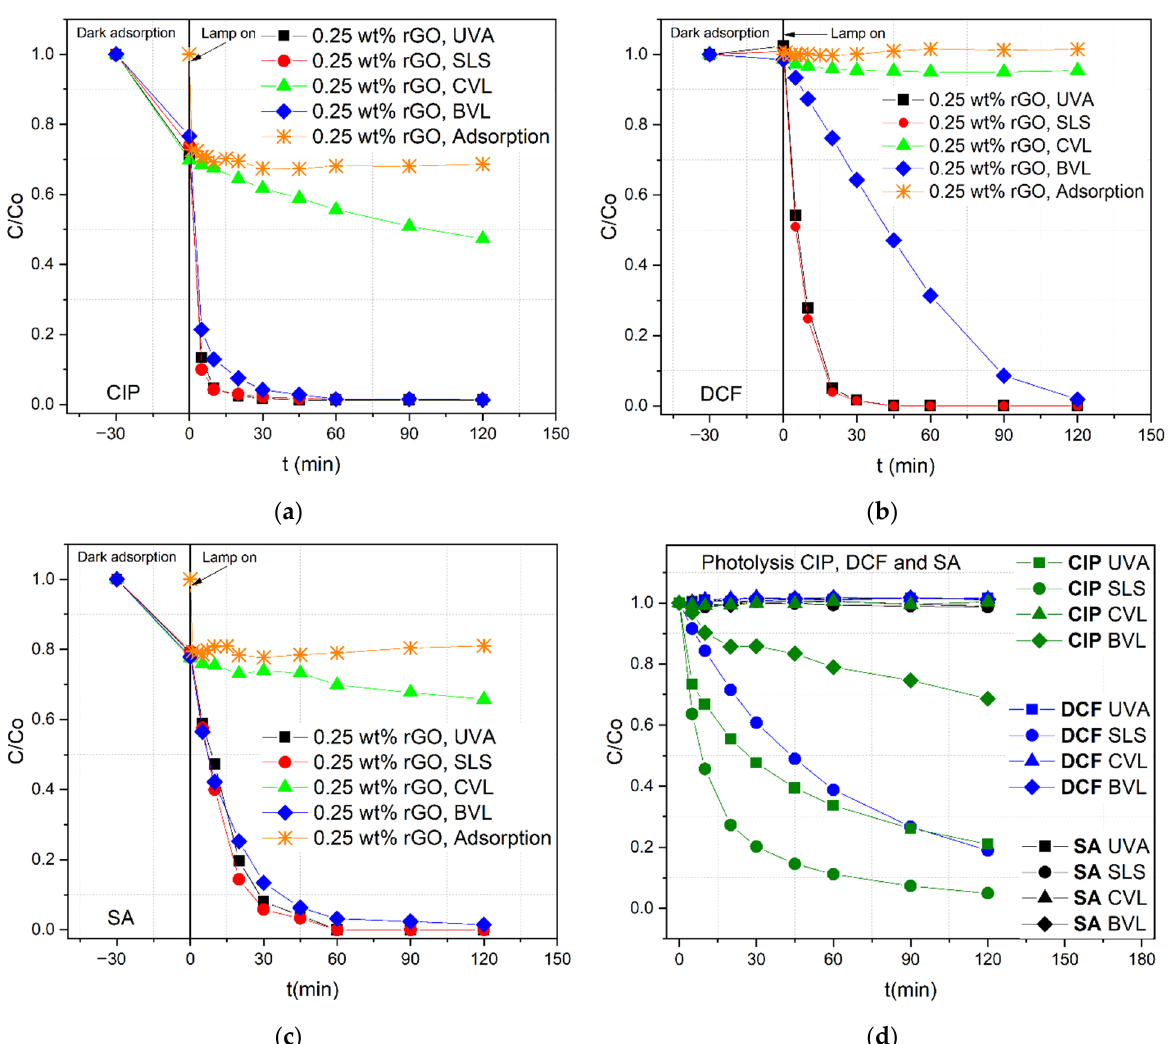
Figure 5. Adsorption and photocatalytic degradation of ( a ) ciprofloxacin (CIP), ( b ) diclofenac (DCF), and ( c ) salicylic acid (SA) by N/TiO 2 /rGO with 0.25 wt.% of rGO material under UVA light, solar light simulator (SLS), cold visible light (CVL), and blue visible light (BVL). ( d ) Photolysis of CIP, DCF, and SA under different irradiation sources.